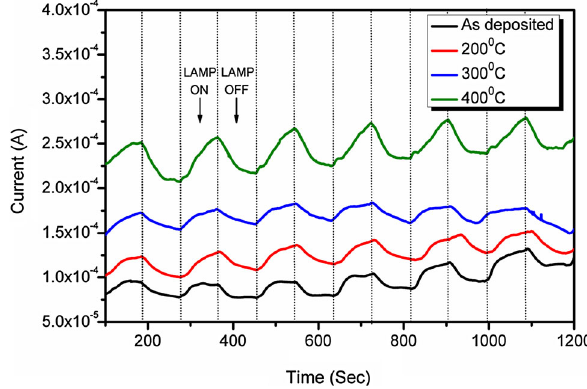
Fig. 8 Current versus time (I–t) plot of as-deposited and calcinated CZTS films at constant 0.2 V bias voltage for 60 s illuminations and for 60 s dark